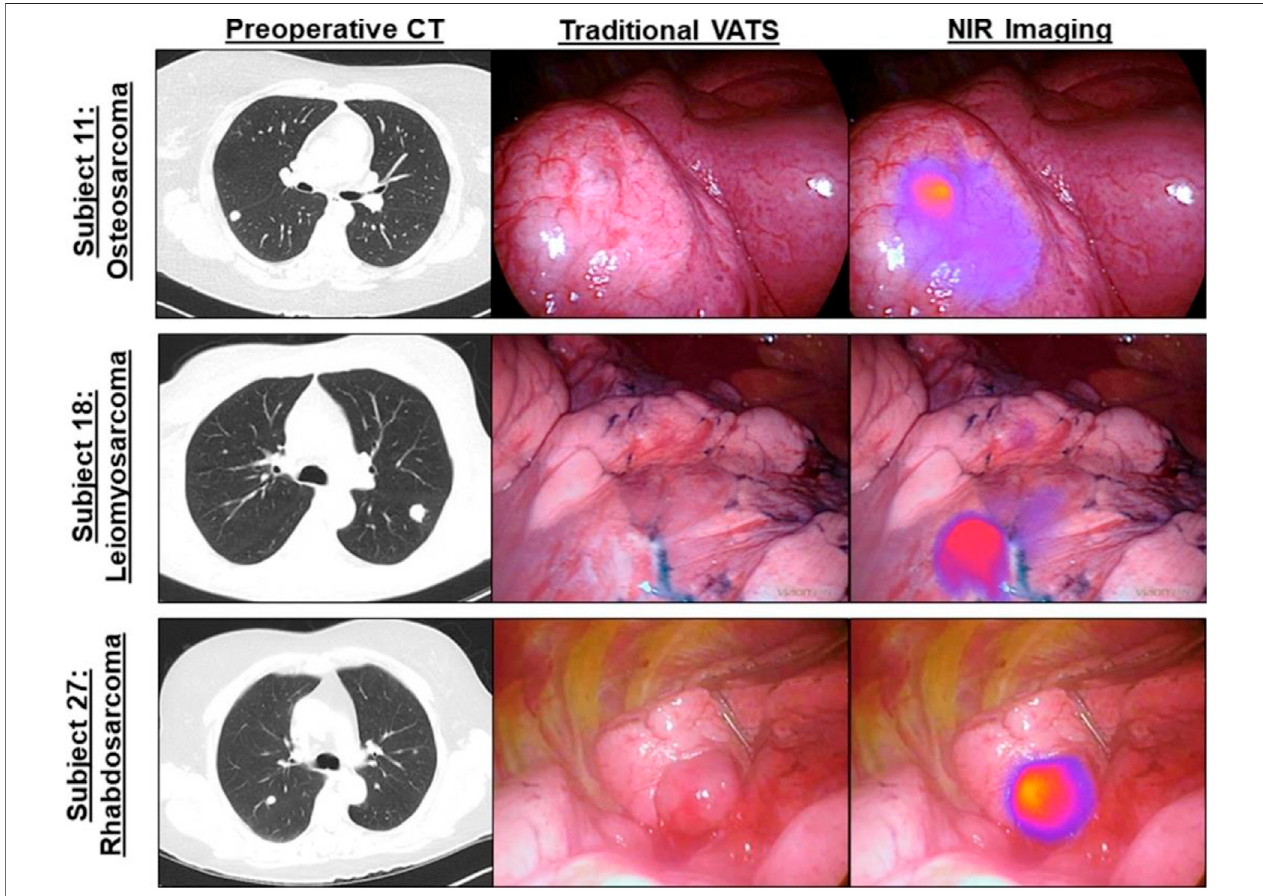
FIGURE 5 | Osteosarcoma metastasis is clearly visualized by NIR intraoperative imaging (ICG) during video-assisted thoracoscopic surgery (VATS) metastasectomy. Left column, preoperative high-resolution computed tomography (CT). Middle column, bright fi eld (traditional views). Right column, NIR merged view. Reproduced with permission from Predina et al.